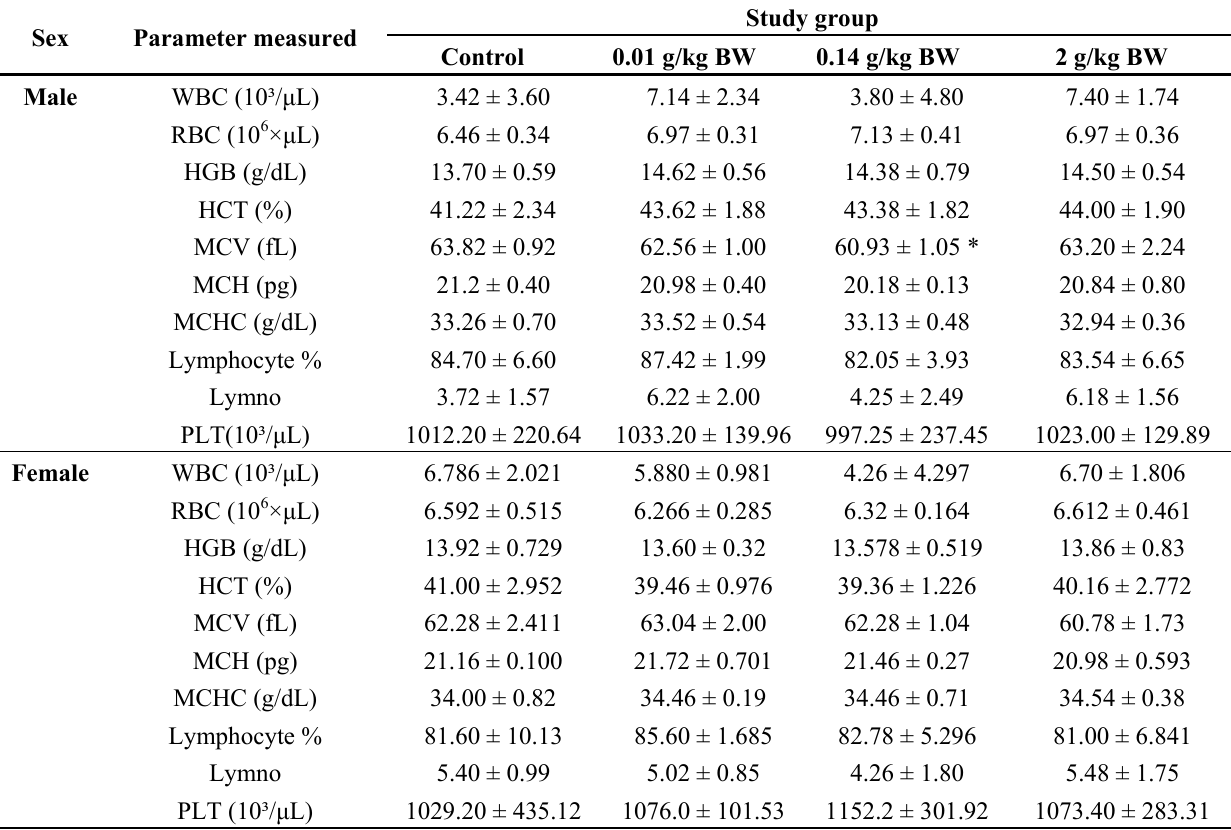
Table 2. Hematological findings from male and female study group, the control and rats treated with C. papaya leaf extracts measured during the 28 days sub-acute toxicity